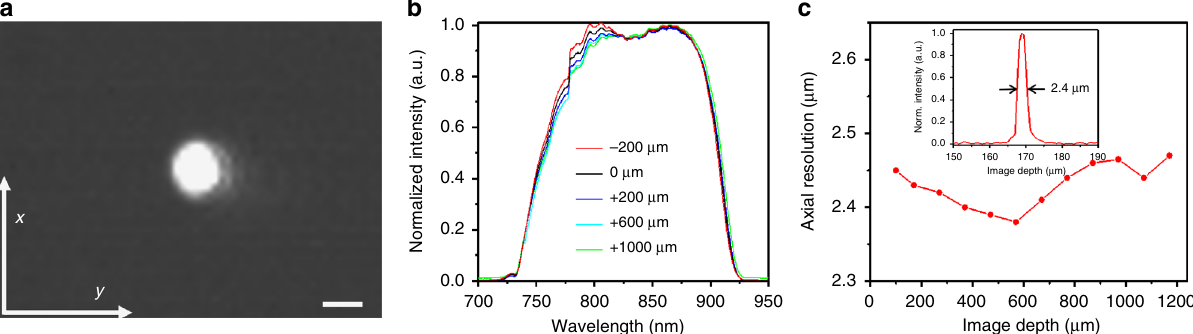
Fig. 4 Characterization of microprobe performance. a Image of the focused spot captured by a charge-coupled device (CCD) camera when the microprobe was encased with a plastic sheath of a 1 mm outer diameter (OD). b Backre fl ected spectra of the microprobe by a mirror placed at different positions along the imaging depth. c Axial resolution measured along the imaging depth. The inset shows a representative point-spread function (PSF) of the microprobe with an 2.4 µ m full-width at half-maximum (FWHM, that is, axial resolution in air). Scale bar is 5 µ microprobe, a spectral-domain OCT (SD-OCT) endoscopy sys- tem as shown in Fig. 3b was employed (see “ Methods ” section).